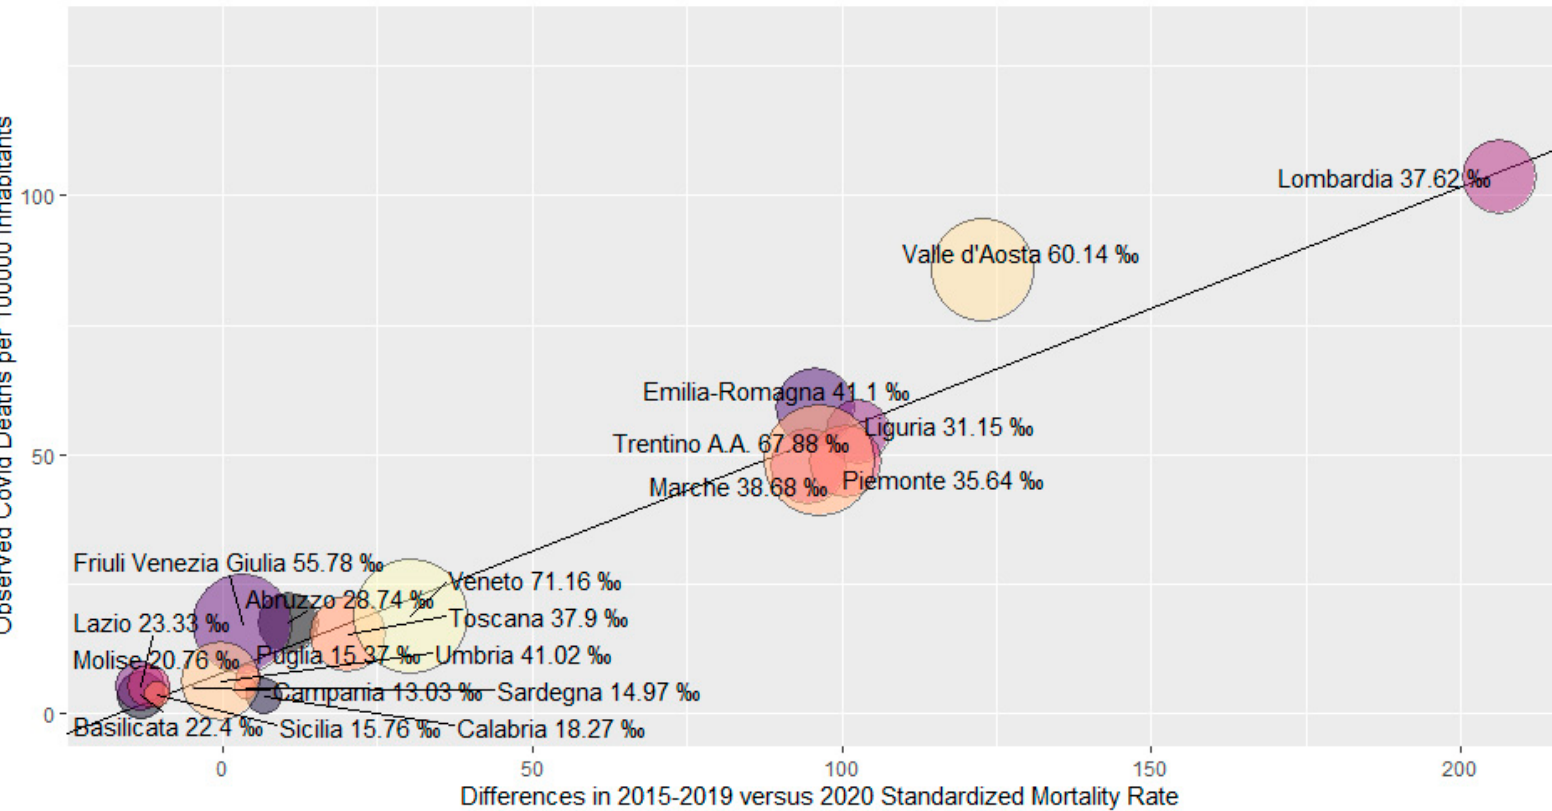
Figure 2. Differences between the 2015–2019 and 2020 Standardized Mortality Rates versus COVID mortality rates per 100,000 inhabitants calculated via weighed ratio estimator. The weights correspond to the probability of swab testing among the population for Italian regions (as of April 30 th ). The size of the circle is proportional to the number of swabs over 1000 inhabitants. The label of the circle includes the name of the region and the number of swabs over 1000 inhabitants. The estimated linear regression line is reported (intercept t = 7.8, slope = 0.47, p value < 0.001)